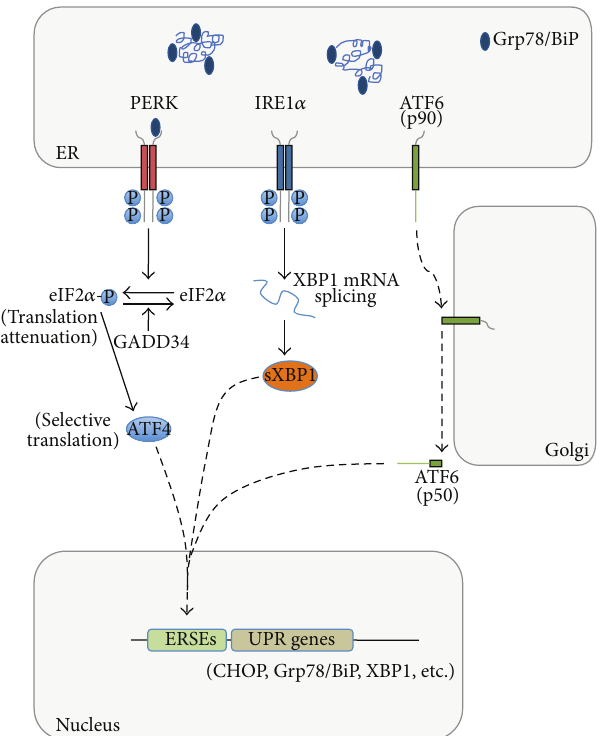
Figure 1: UPR signaling pathways in mammalian cells. The UPR is mediated by three ER-resident transmembrane proteins that sense ER stress through Grp78/BiP binding/release to their luminal domains and/or through direct interaction with unfolded proteins. The kinase PERK (double-stranded RNA-activated protein kinase-like ER kinase) is activated by dimerization and phosphorylation. Once activated, it phosphorylates eIF2 𝛼 (eukaryotic translation initiation factor 2). This inhibits protein translation, reducing the overload of misfolded proteins. This pathway also selectively enhances translation of ATF4 (activating transcription factor 4) that induces the expression of CHOP. In ER-stressed cells, IRE1 𝛼 (inositol-requiring transmembrane kinase and endonuclease) multimerizes and autophosphorylates, setting in motion its RNAse activity. Activated IRE1 𝛼 initiates the unconventional splicing of the mRNA encoding the transcriptional factor XBP1 (X-box-binding protein 1) to produce sXBP1, a more stable form of XBP1 with a potent transactivator domain that enhances transcription of genes involved in protein folding, secretion, and ER-associated degradation. Another ER stress sensor is ATF6 (activating transcription factor 6). This is a type II ER transmembrane protein whose cytosolic domain contains a bZIP transcriptional factor. ATF6 is transported to the Golgi where it is processed within the transmembrane domain to release the cytosolic domain, which translocates to the nucleus and induces expression of the ER chaperone Grp78/BiP and XBP1. GADD34, a protein phosphatase upregulated by the PERK pathway, dephosphorylates eIF2 𝛼 to restore global protein synthesis. ERSEs: ER stress responsive